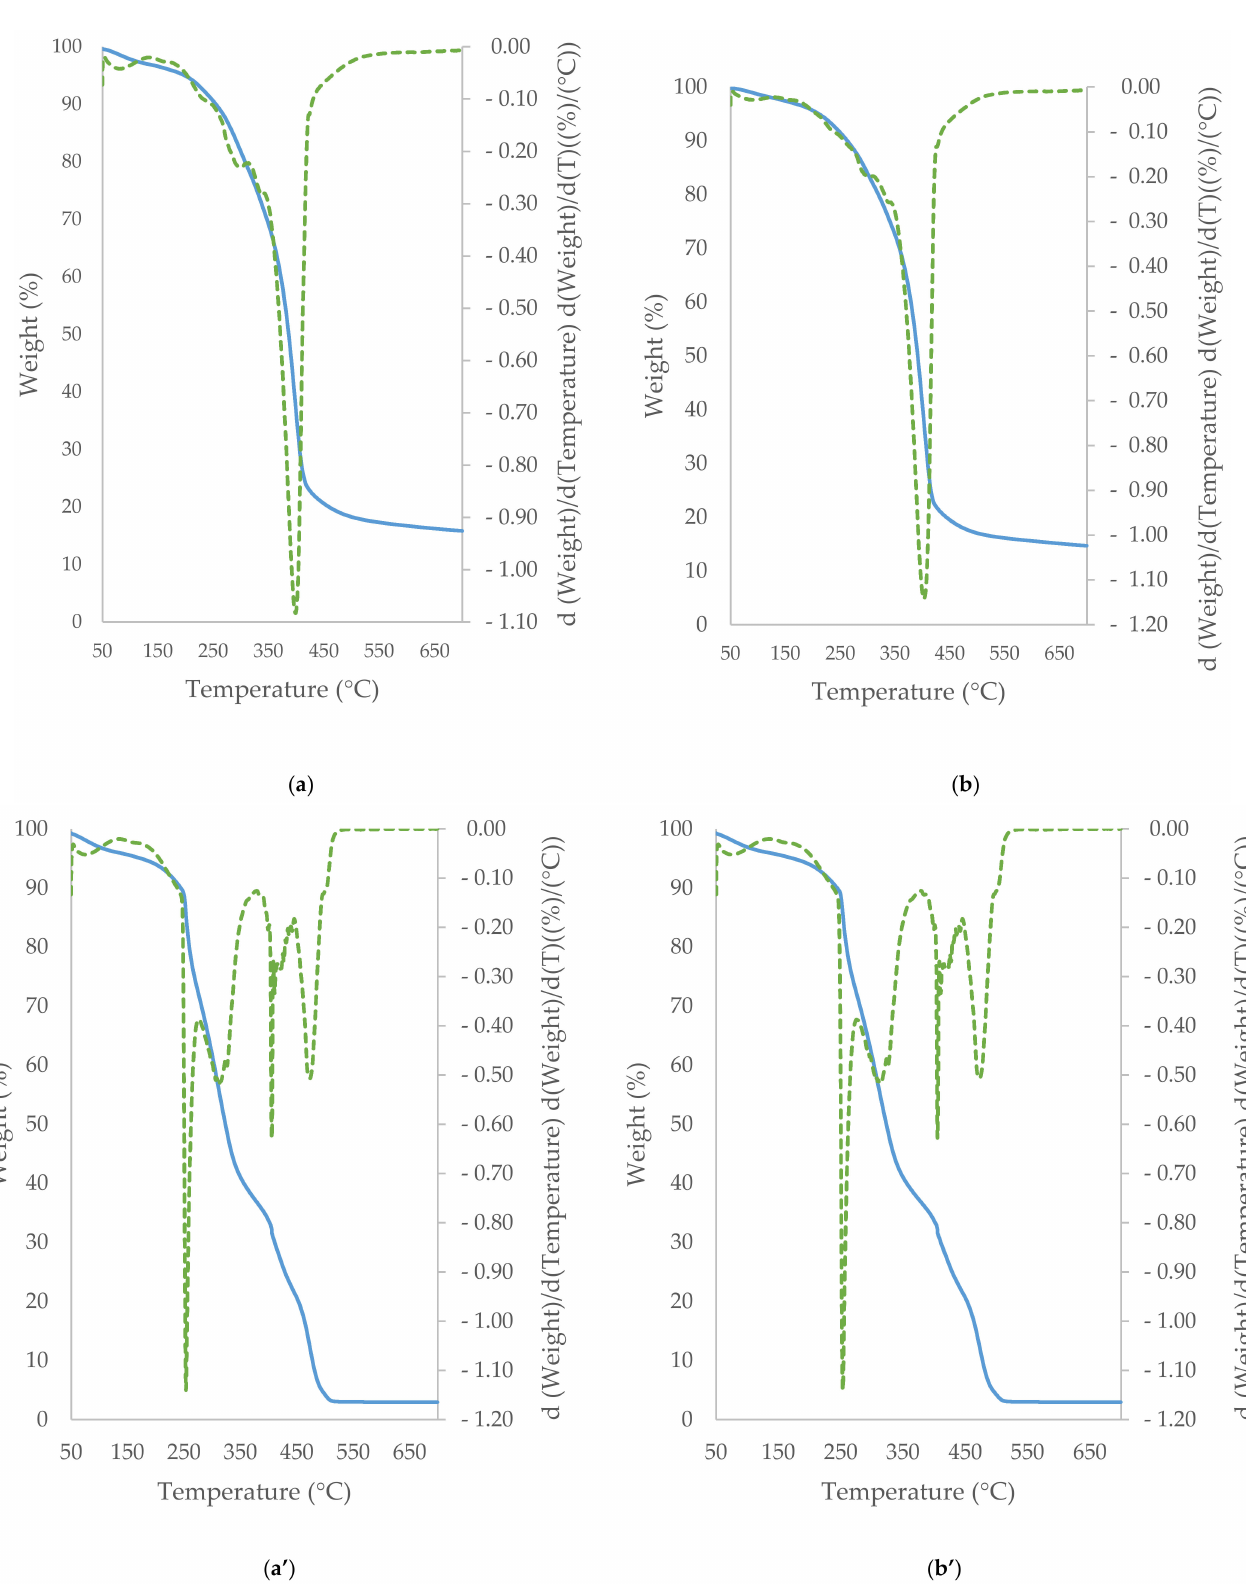
Figure 3. Thermogravimetry (TGA) and DTG curves of ground Criollo (Peru), unroasted ( a ) in nitrogen ( a’ ) in oxygen and roasted ( b ) in nitrogen and ( b’ ) in